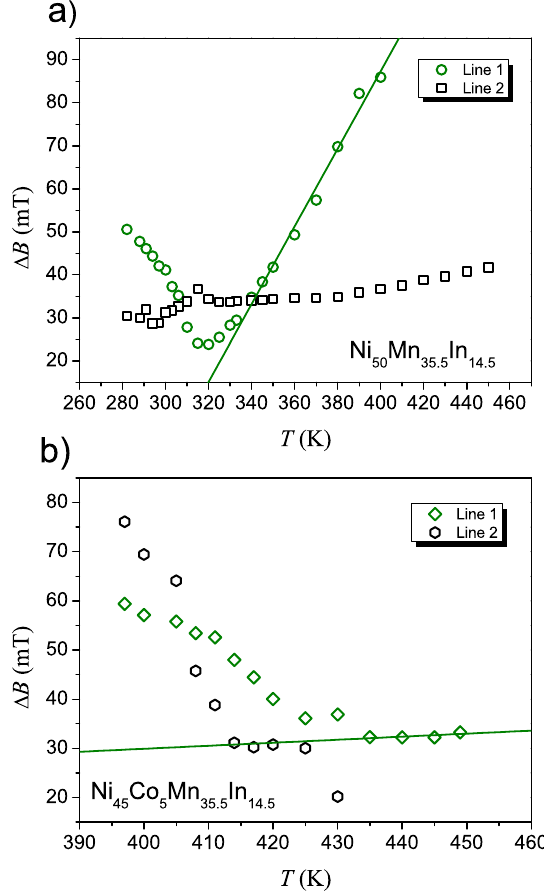
Figure 5. Temperature dependence of the EMR linewidth ∆ B for Ni 50 Mn 35.5 In 14.5 r ( a ) and Ni 45 Co 5 Mn 35.5 In 14.5 ( b ) ribbons. The solid lines represent the best fit of the linewidth above T C , using the expression